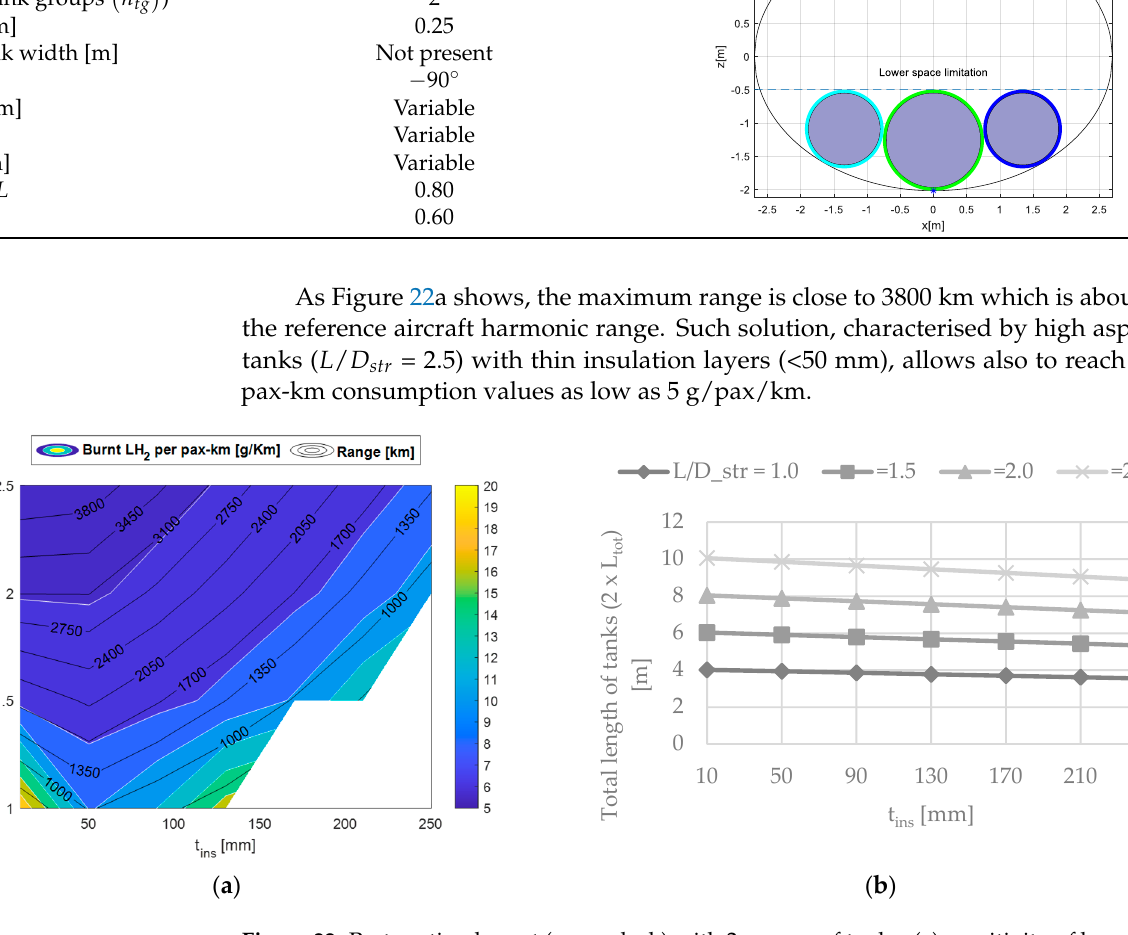
Figure 22. Part-section layout (cargo deck) with 2 groups of tanks: ( a ) sensitivity of burnt LH 2 per pax-km to 𝐿/𝐷 𝑠𝑡𝑟 and 𝑡 𝑖𝑛𝑠 , ( b ) total length of tanks (2 groups).